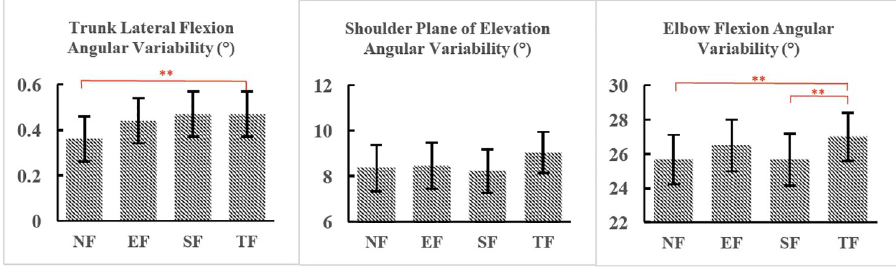
Fig 4. Joint angular variabilities between conditions (NF vs EF vs SF vs TF). � NF, EF, SF and TF represent non- fatigued RPT, elbow fatigued RPT, shoulder fatigued RPT and trunk fatigued RPT respectively. The letters after � above the bars indicate significant differences. � indicates p < 0.05, �� indicates p <